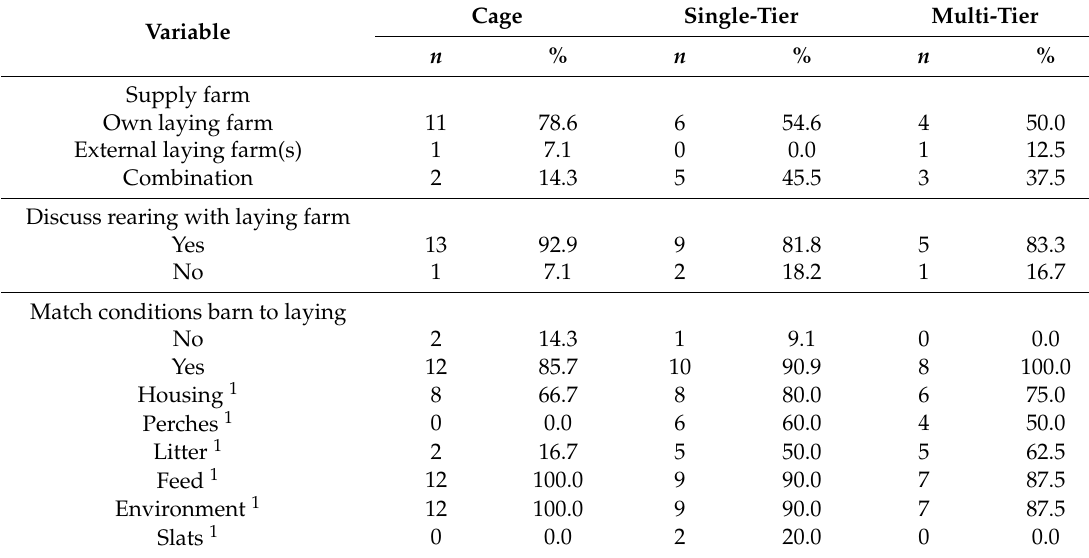
Table 7. Description of flock rearing and placement practices for 33 pullet flocks placed between May and November 2017 according to housing system (cage n = 14, single-tier n = 11, multi-tier n = 8) in